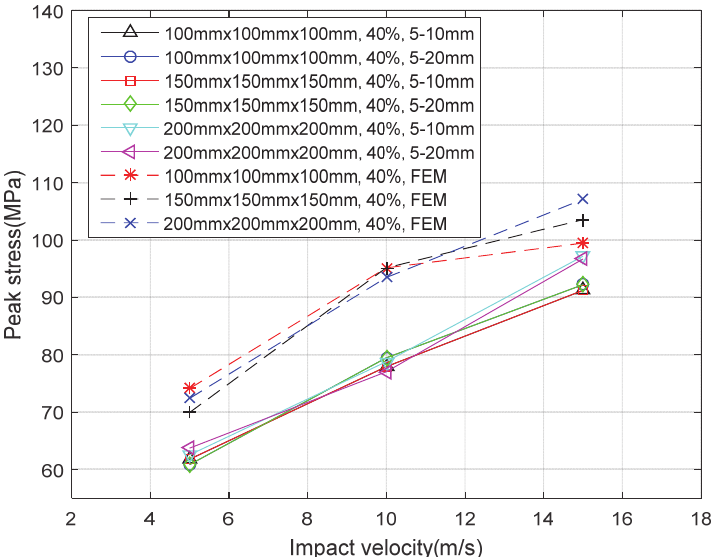
Figure 5: Relationship between the peak stress and the loading